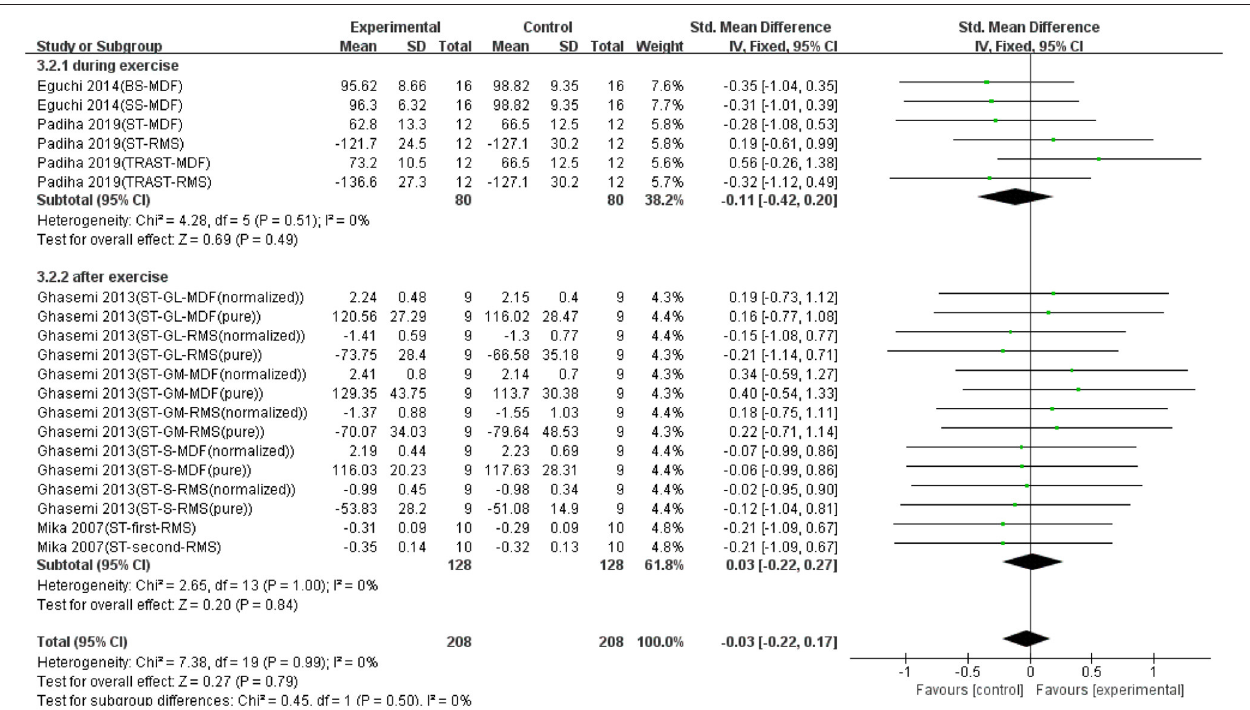
FIGURE 3 | The effectiveness of stretching (ST) conducted at different time points on electromyography (EMG) signals of exercise-induced muscle fatigue.